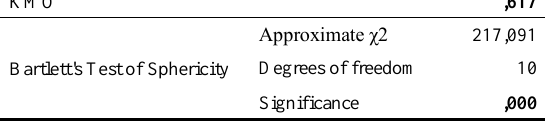
Table 3. Results of the KMO and Bartlett´s test.